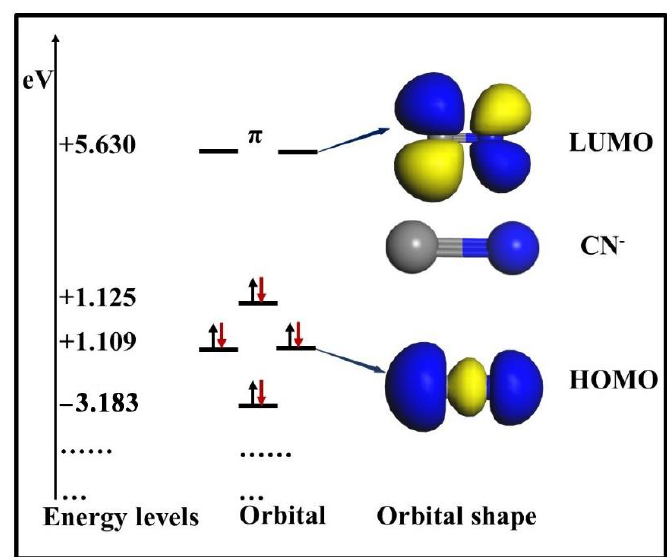
Figure 7. Energy levels and orbital shapes of CN −